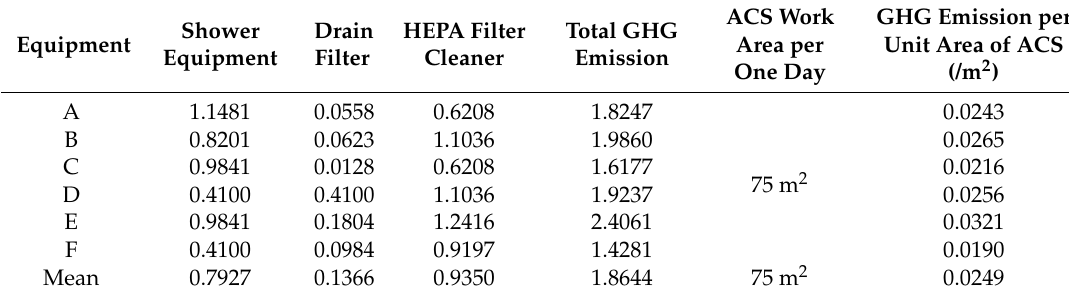
Table 8. GHG emission of electric-powered equipment (unit: kgCO 2 eq).